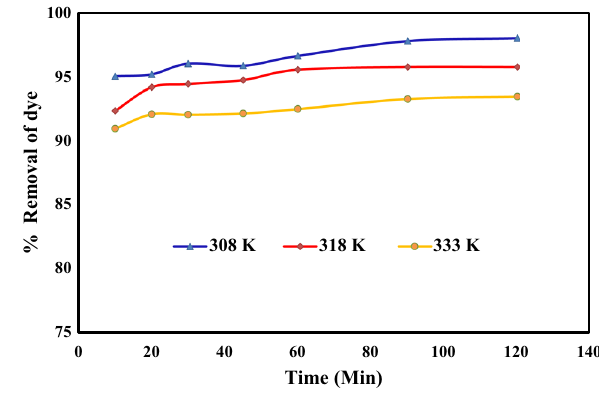
Fig. 6 Effect of solute concentration on removal of MG (NLP: 3 g/l,